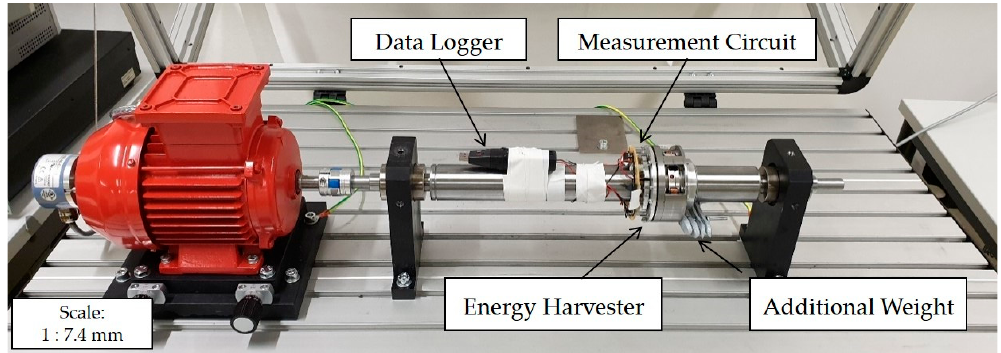
Figure 5. Experimental setup for evaluating the Energy Harvester principle.